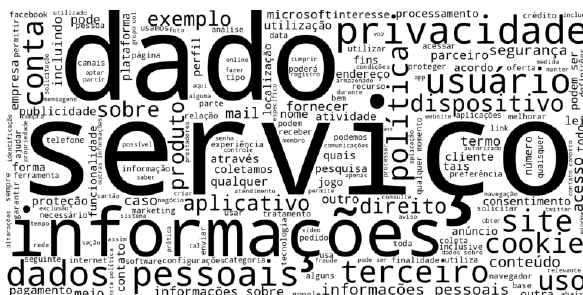
Figure 5. Most used words in the